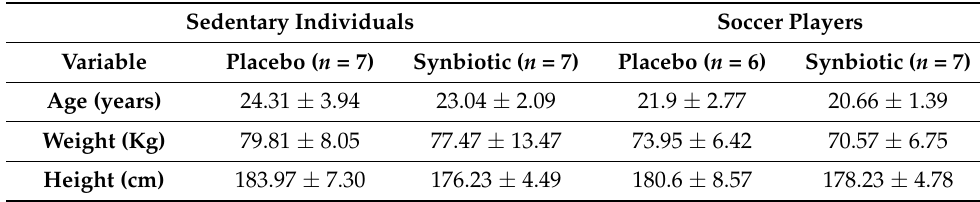
Table 1. Descriptive data of the